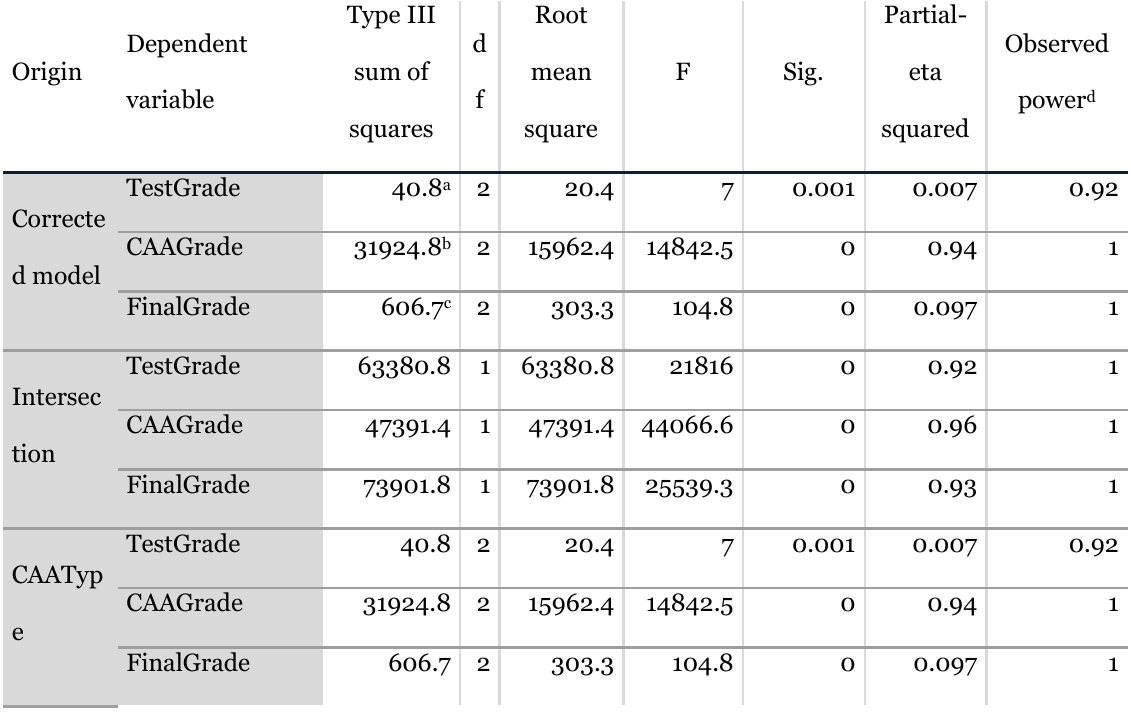
Tests of Between-Subjects Effects: Estimates of Effect